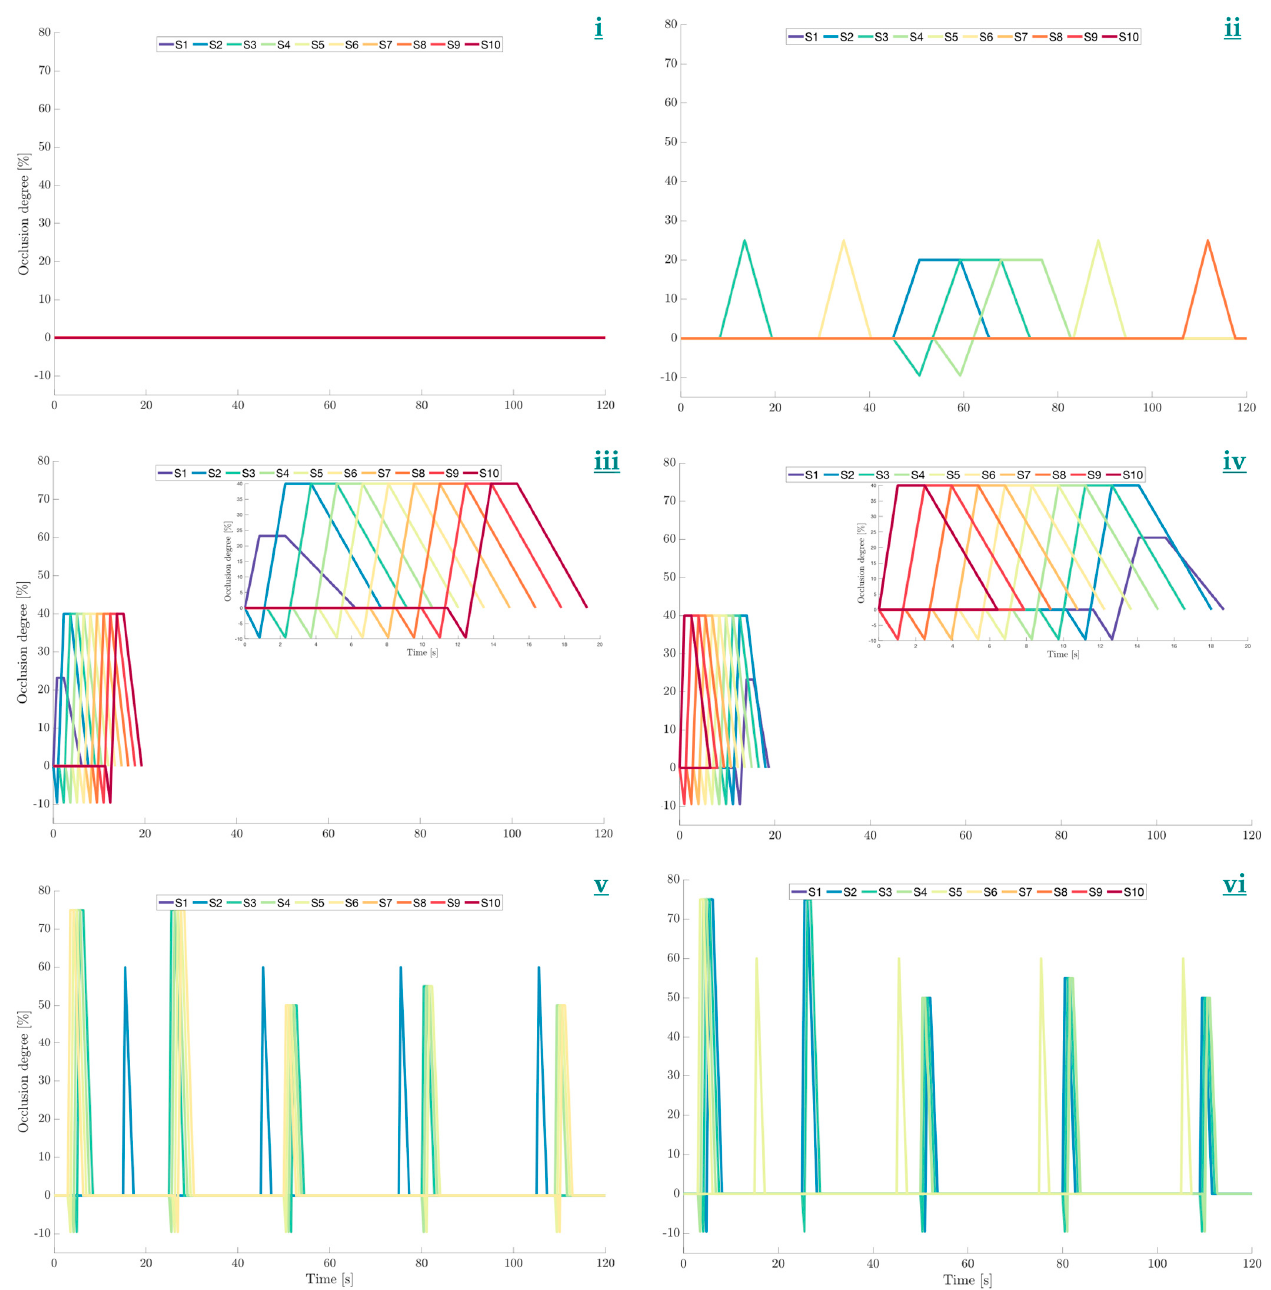
Figure 2. Motility patterns applied to the DCM. ( i ) Static, ( ii ) Baseline [12], ( iii ) Antegrade CPPW, ( iv ) Retrograde CPPW, ( v ) PEG stimulated motility and ( vi ) Maltose stimulated motility. Inset figures are placed in C and D to show the motility of each CPPW in more detail.